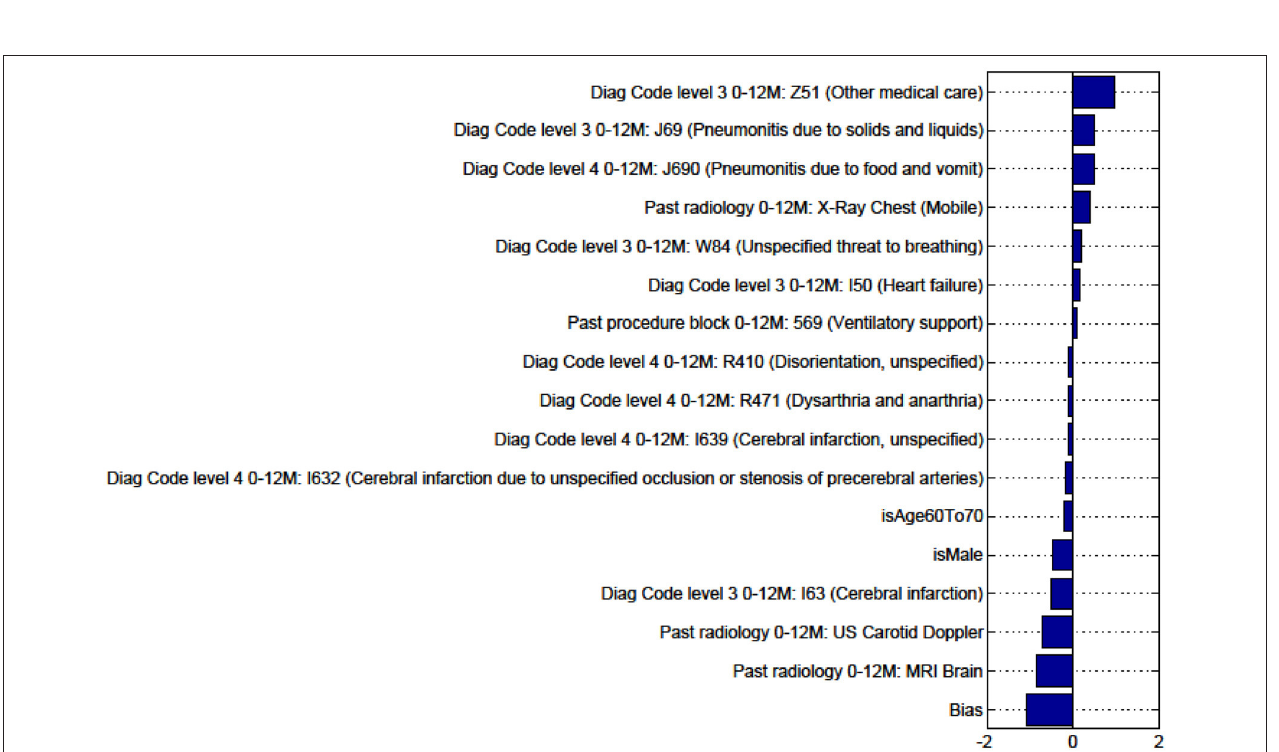
FIGURE A8 | Factors for prediction of Death vs Discharge to all Other discharge destinations for the sub-cohort of ischemic stroke patients.